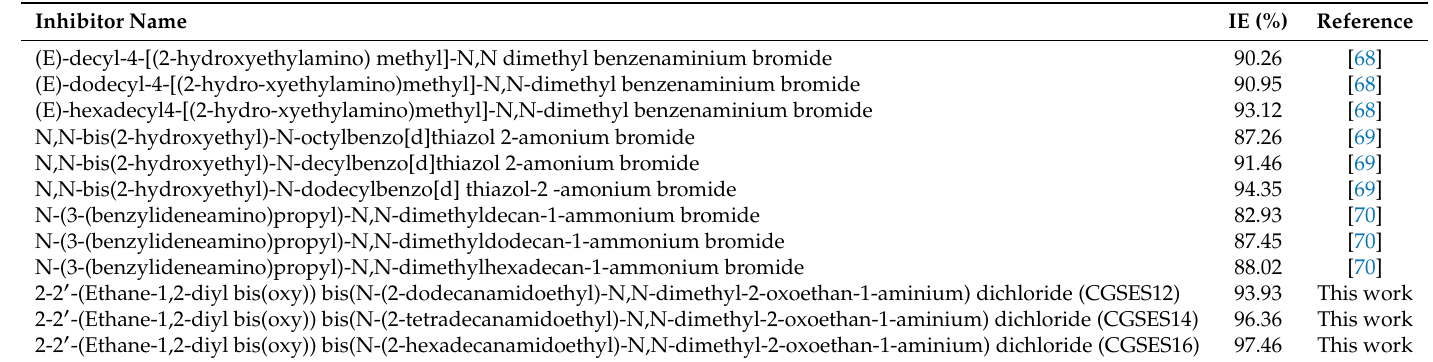
Table 10. The comparison between the tested compounds and other inhibitors reported in the literature for anti-corrosion protection of steel at the same experiment